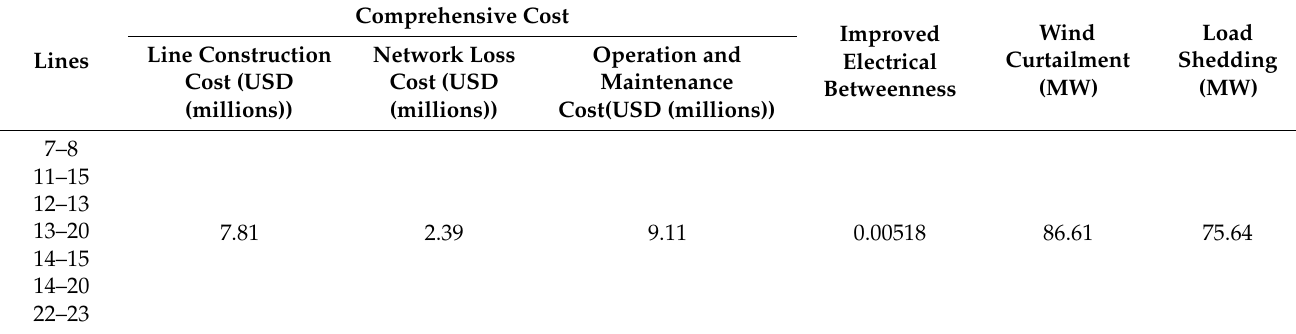
Table 7. TNEP scheme of PSO in modified IEEE RTS-24 bus